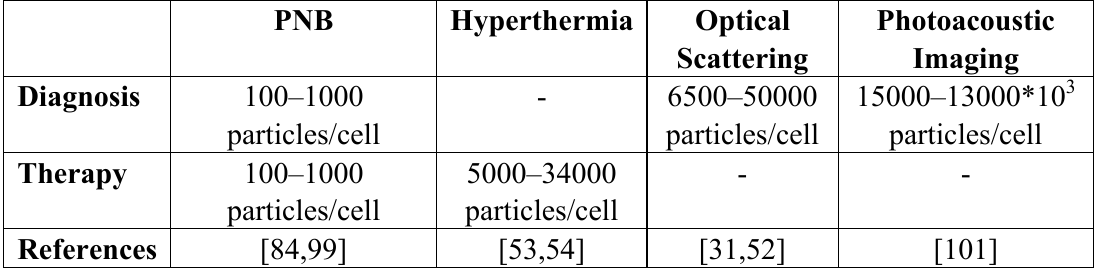
Table 2. Gold NP load in a cell for the NP-based diagnosis and therapy with different